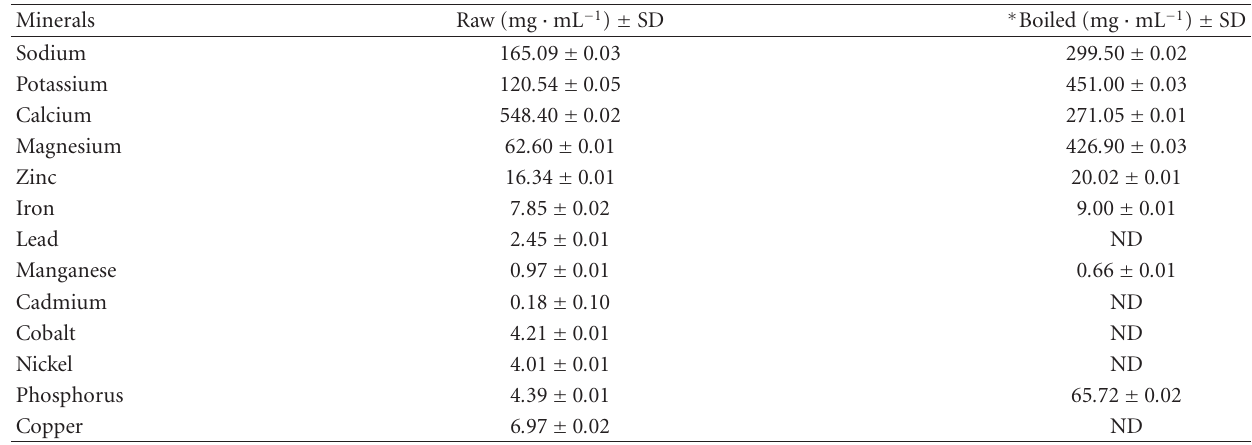
Table 2: Mineral composition of Parkia biglobosa seeds.